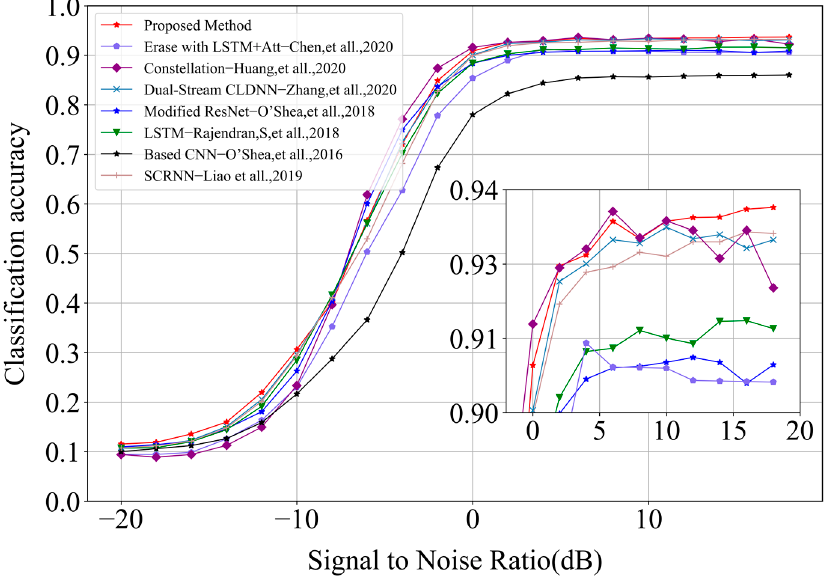
Figure 13. Comparison of recognition accuracy of models under different SNRs [11–14,16–18].